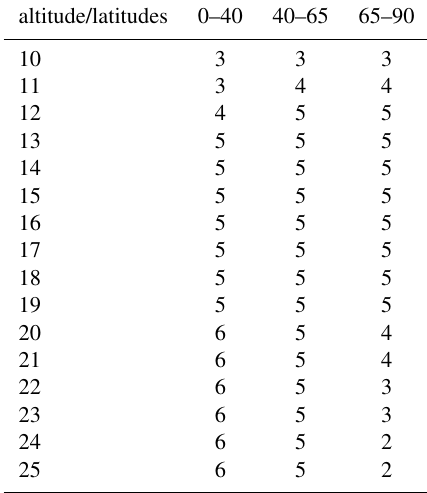
Table A1. Variable CI thresholds between 10 and 25km derived from Sembhi et al.